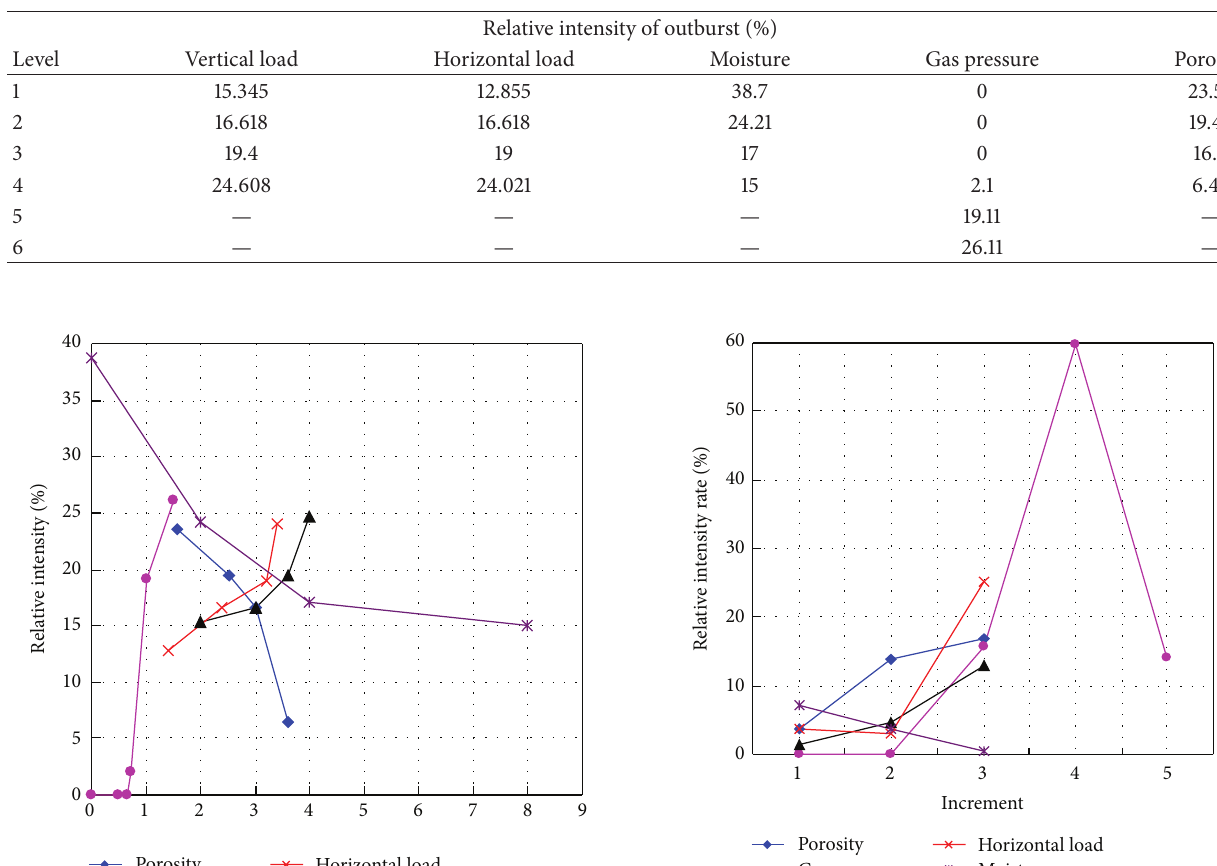
Table 2: Relative intensity of outburst in coal and gas.